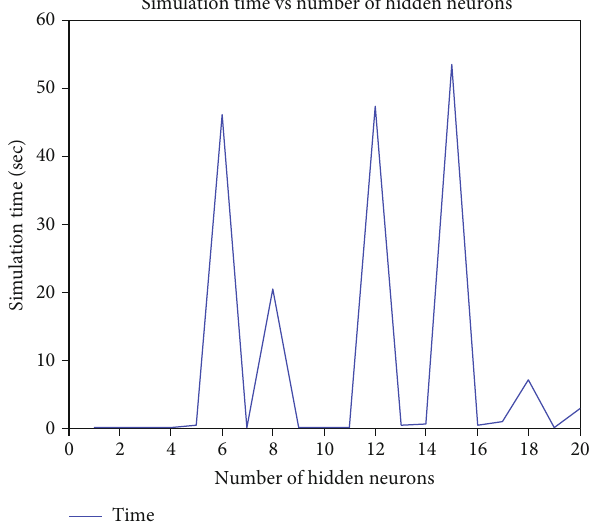
Figure 19: Six input MLPNN-based forecasting model simulation times vs. the number of hidden